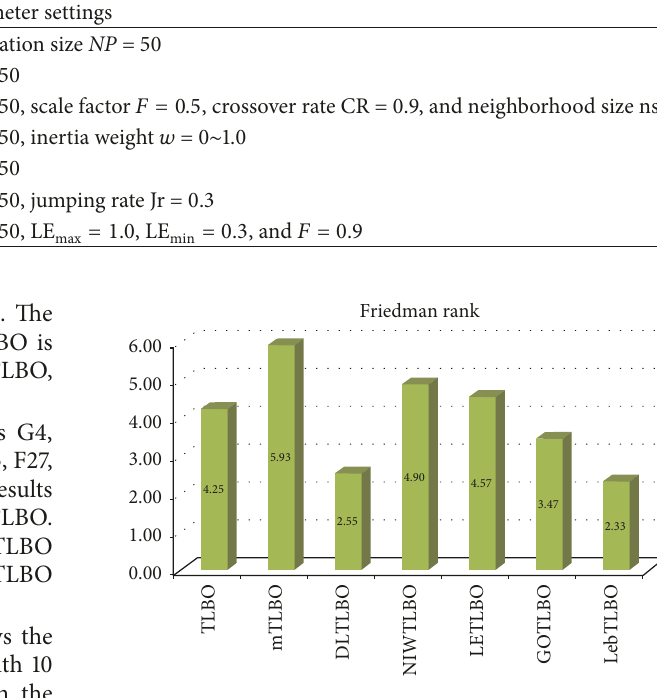
Figure 3: Friedman rankings of the compared TLBO